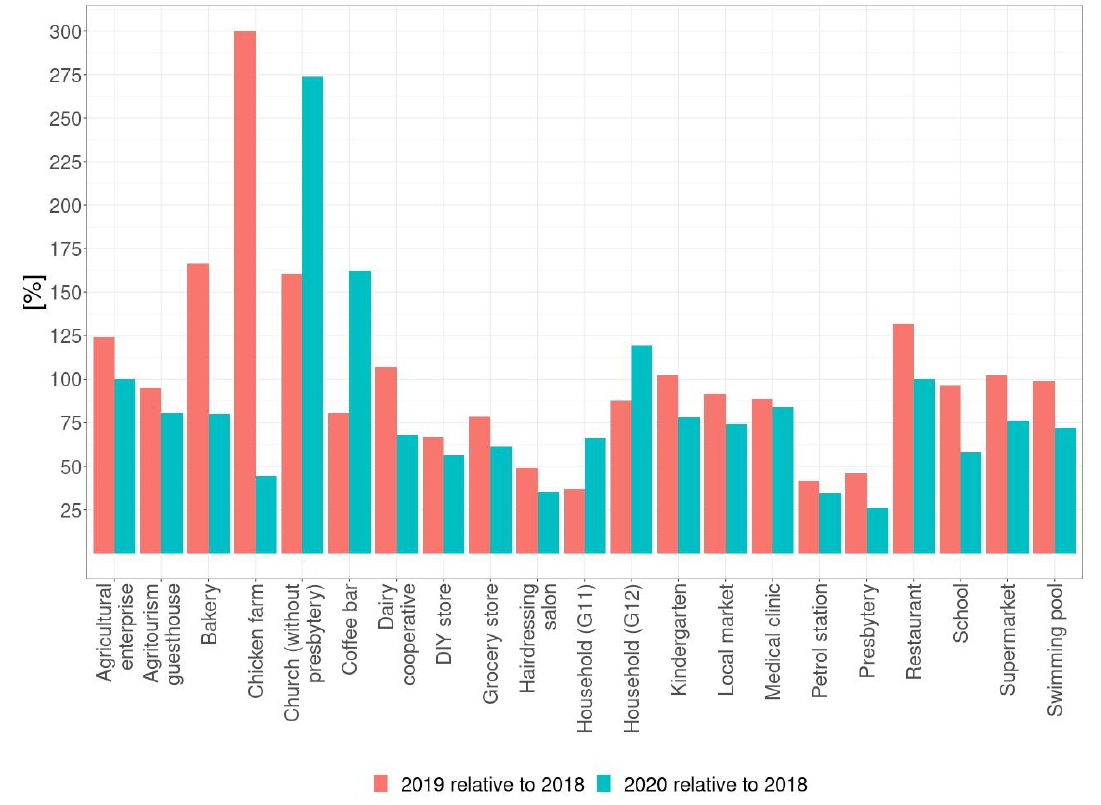
Energies 2021 , 14 , x FOR PEER REVIEW Figure 6. Change in the electricity off-take/purchase from the network depending on the prosumer and year of analyses.